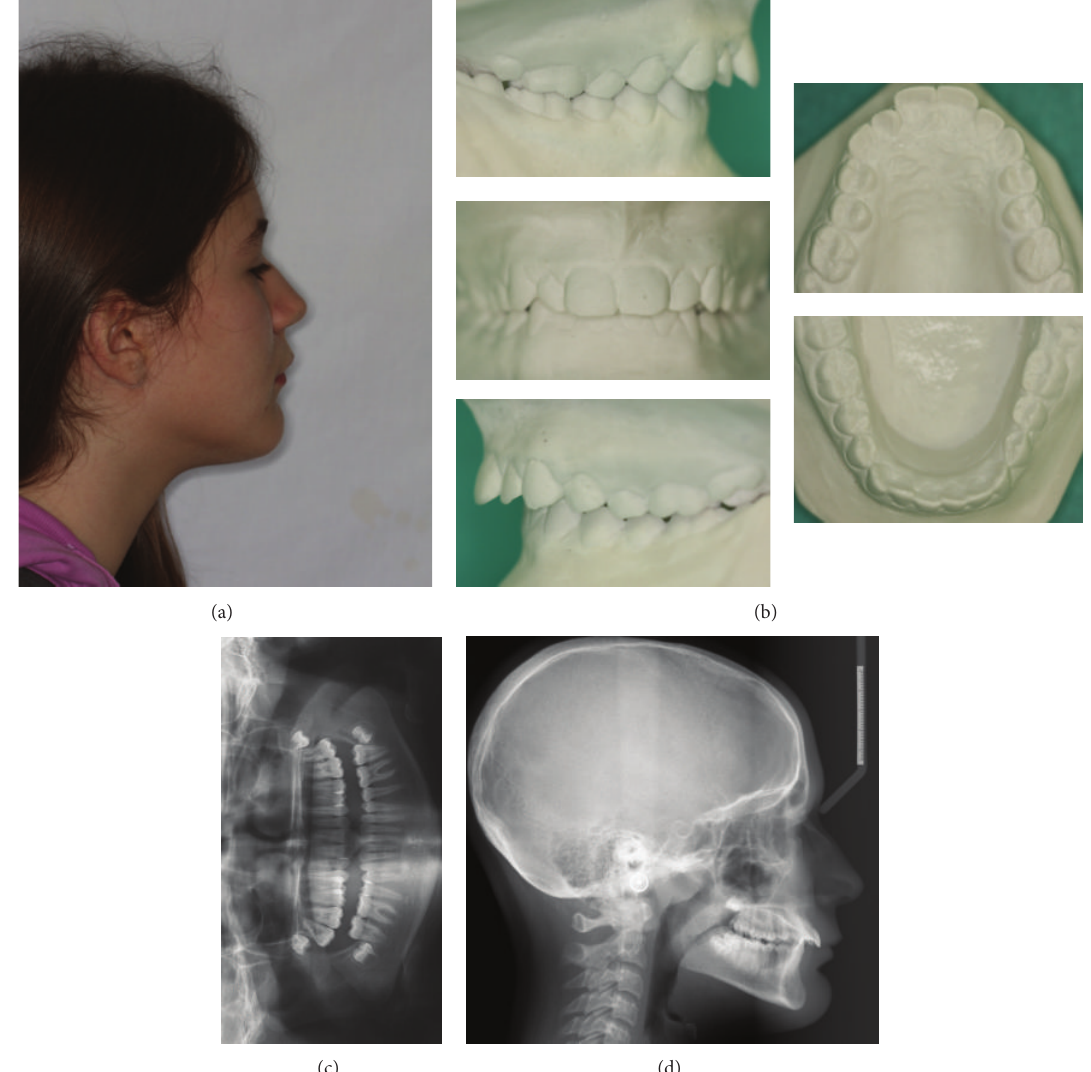
Figure 2: Pretreatment records: (a) extraoral profile photo, (b) dental casts, (c) panoramic radiograph, and (d) cephalometric